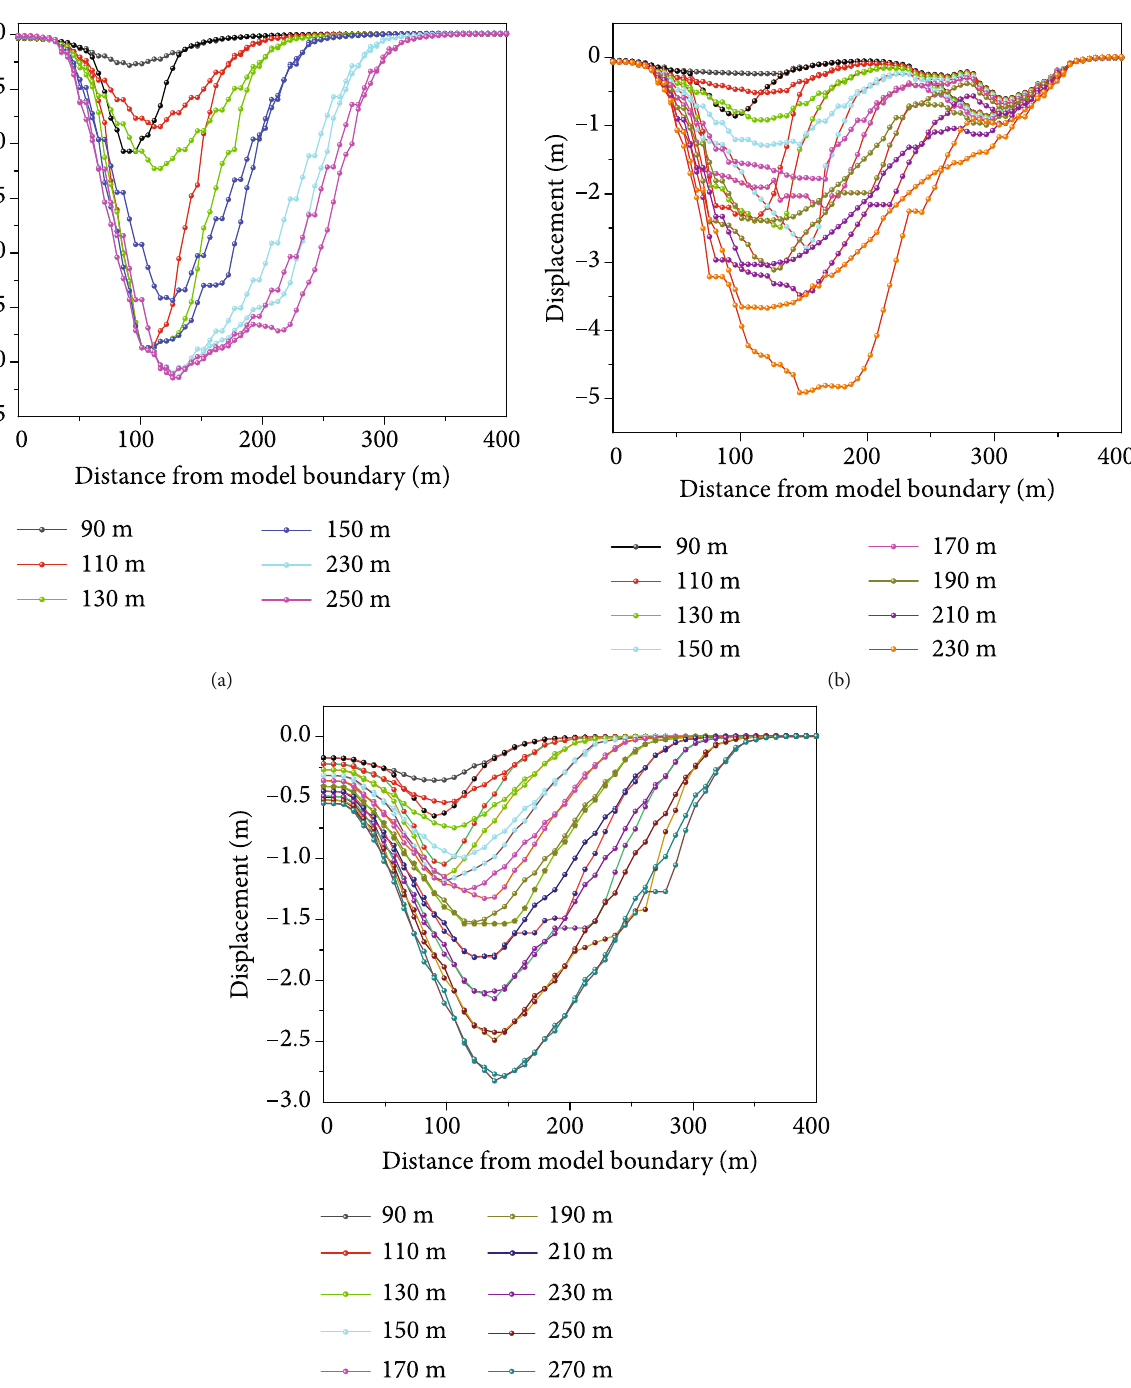
Figure 8: Displacement curve ((a) – (c) are the subsidence curves when mining coal 1, coal 2, and coal 3,